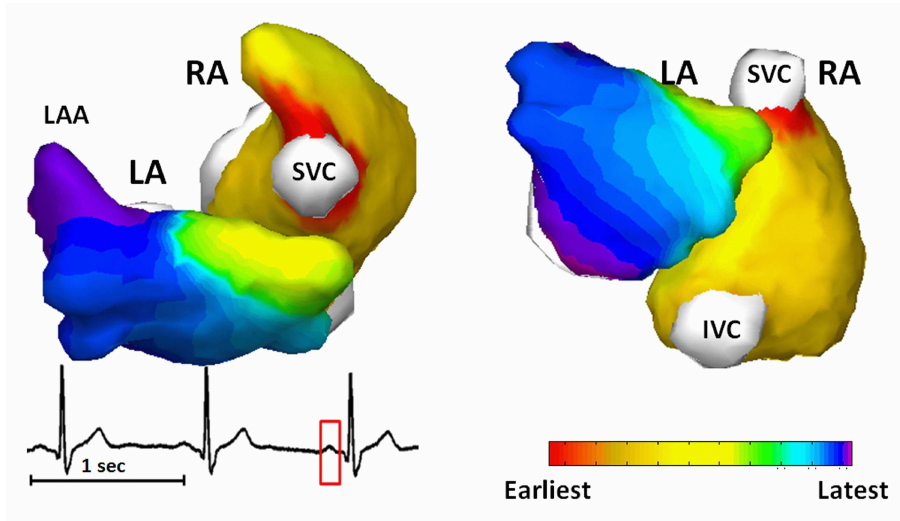
Fig 2. Imaged normal atrial activation from subject NS5. IVC = Inferior vena cava; LA = Left atrium; LAA = Left atrial appendage; RA = Right atrium; SVC = Superior vena cava.